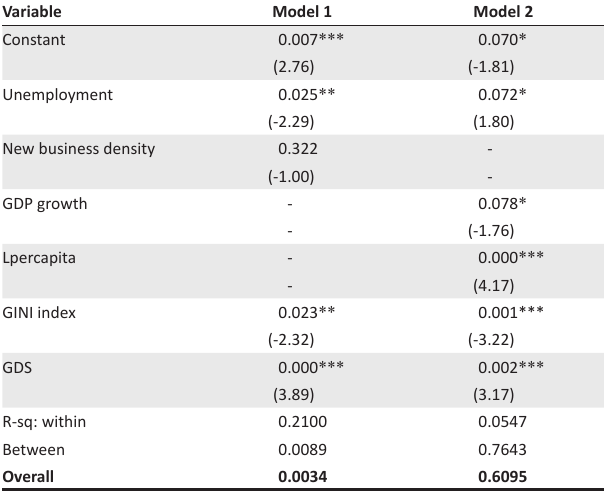
TABLE 1: Estimated results over the period